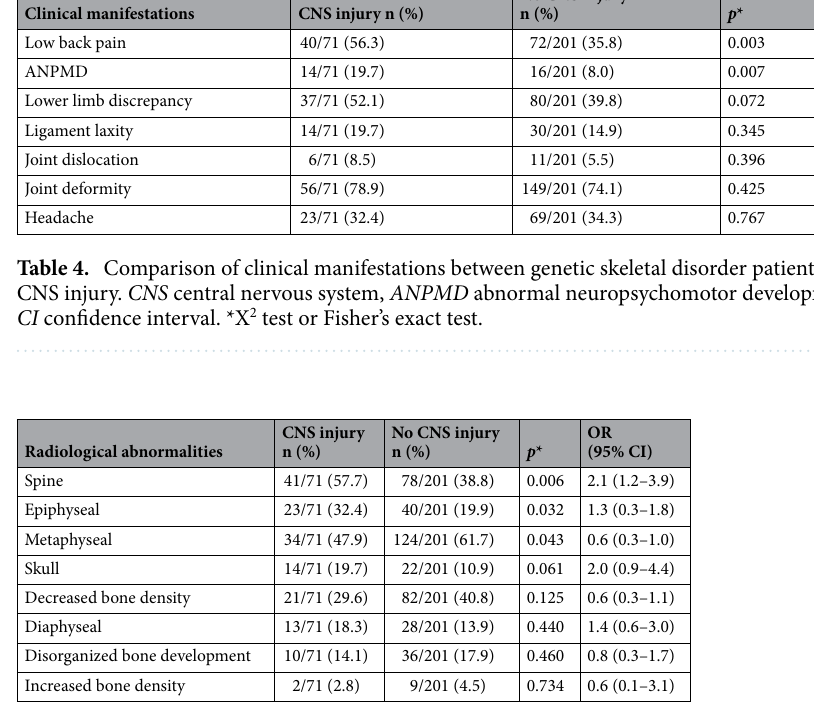
Table 5. Comparison of radiological abnormalities between genetic skeletal disorder patients with and without CNS injury. CNS central nervous system, OR odds ratio, CI confidence interval. *X 2 test or Fisher’s exact test.